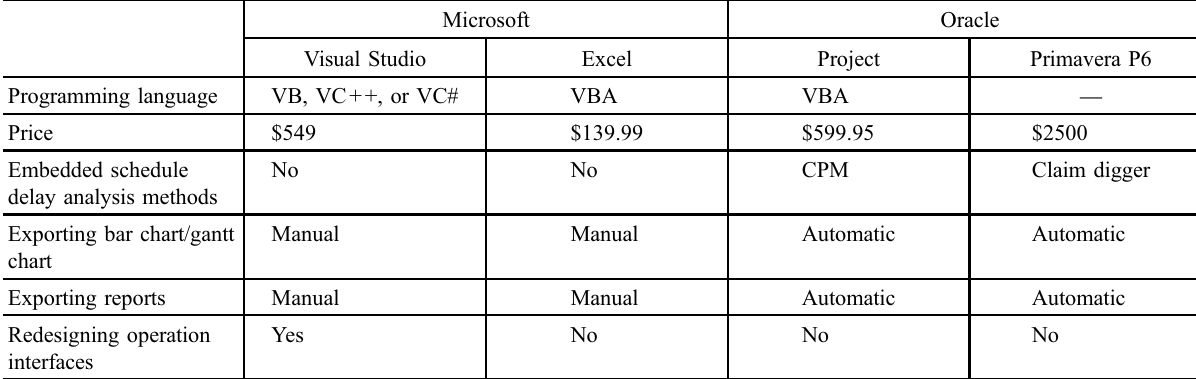
Table 2. A comparison of various development tools